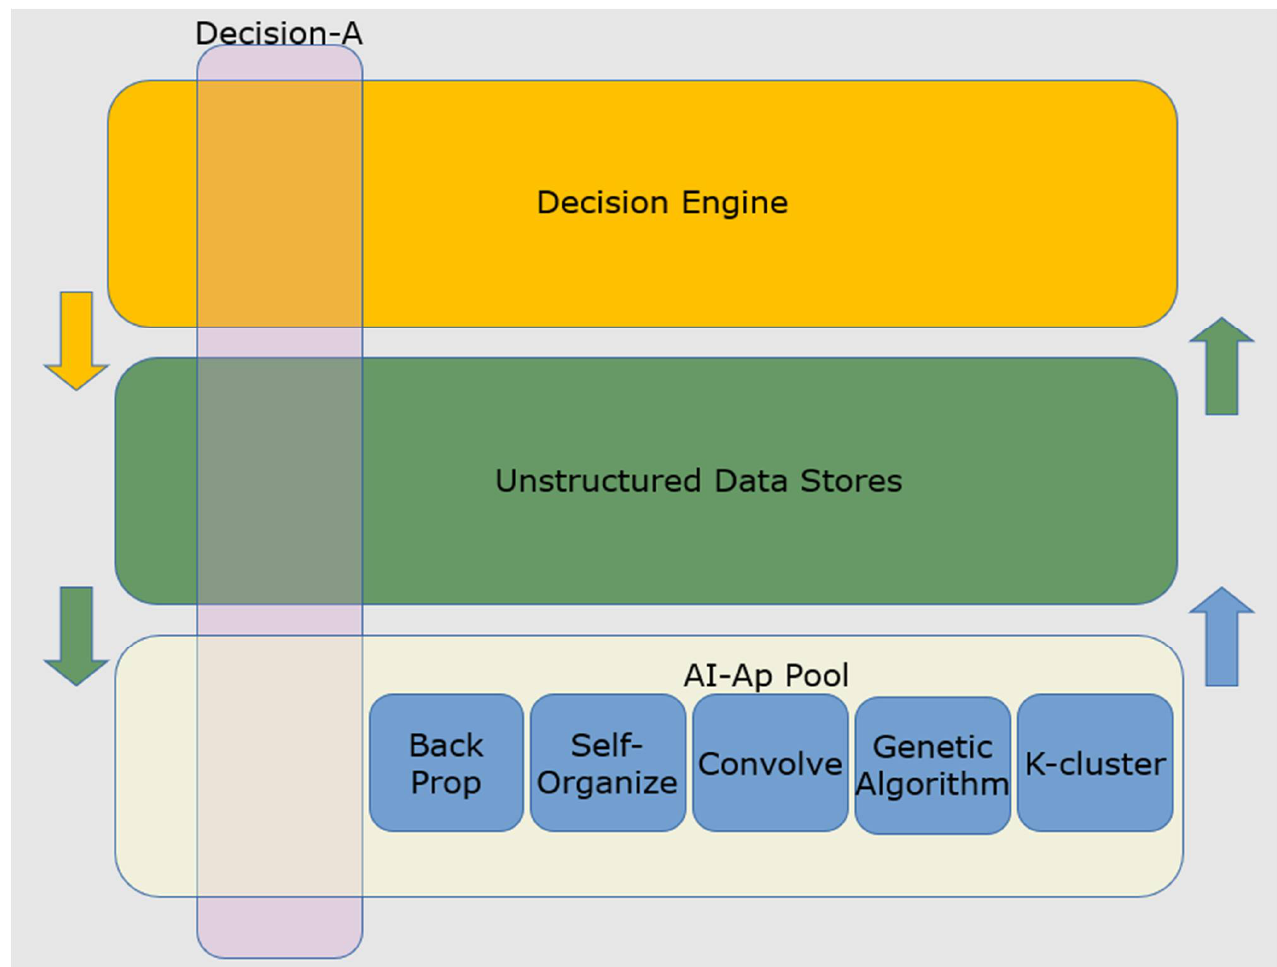
Figure 4. The decision stack for an AI decision machine. Pictured above is a schematized reference architecture upon which an AI decision stack (translucent pink) must operate. At the base are ho- mogenous or heterogeneous populations of ML algorithms (AI-Ap Pool) that run on unstructured data. The examples in the figure include back propagation artificial neural networks, self-organizing networks, convolution algorithms, genetic algorithms, and K-clustering statistical methods. Datas- tores are implemented at the middle level. Such datastores, physically distributed, are accessed at the base of the reference architecture and the top as schematized by the arrows. At the top level is a decision engine that acts as a read-out of the entire decision stack. The decision engine acts as a read- out and an integral component of the decision stack that may implement some machine learning.